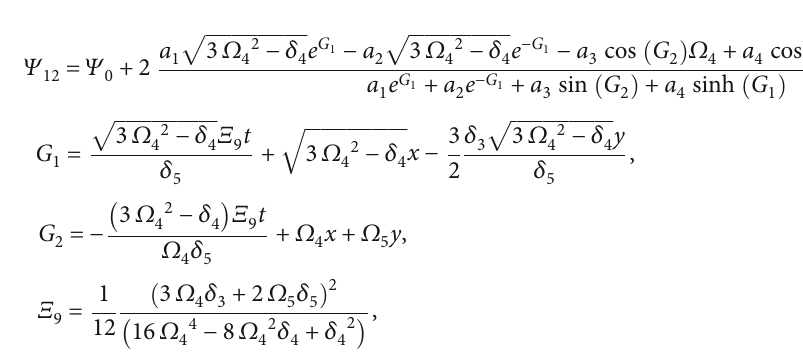
p ffiffiffiffiffiffiffiffiffiffiffiffiffiffiffiffiffiffiffiffi 3 Ω 42 − δ Þ